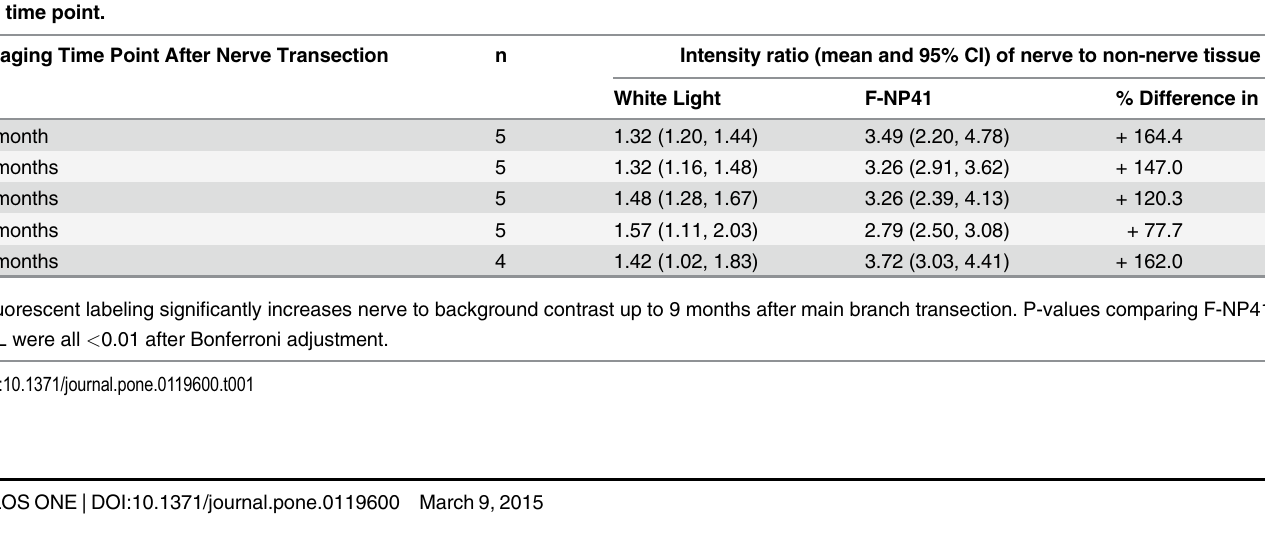
Table 1. Mean intensity ratios and the 95% con fi dence intervals of degenerated nerve to non-nerve tissue for white light and fl uorescent images by time point. Imaging Time Point After Nerve Transection n Intensity ratio (mean and 95% CI) of nerve to non-nerve tissue White Light